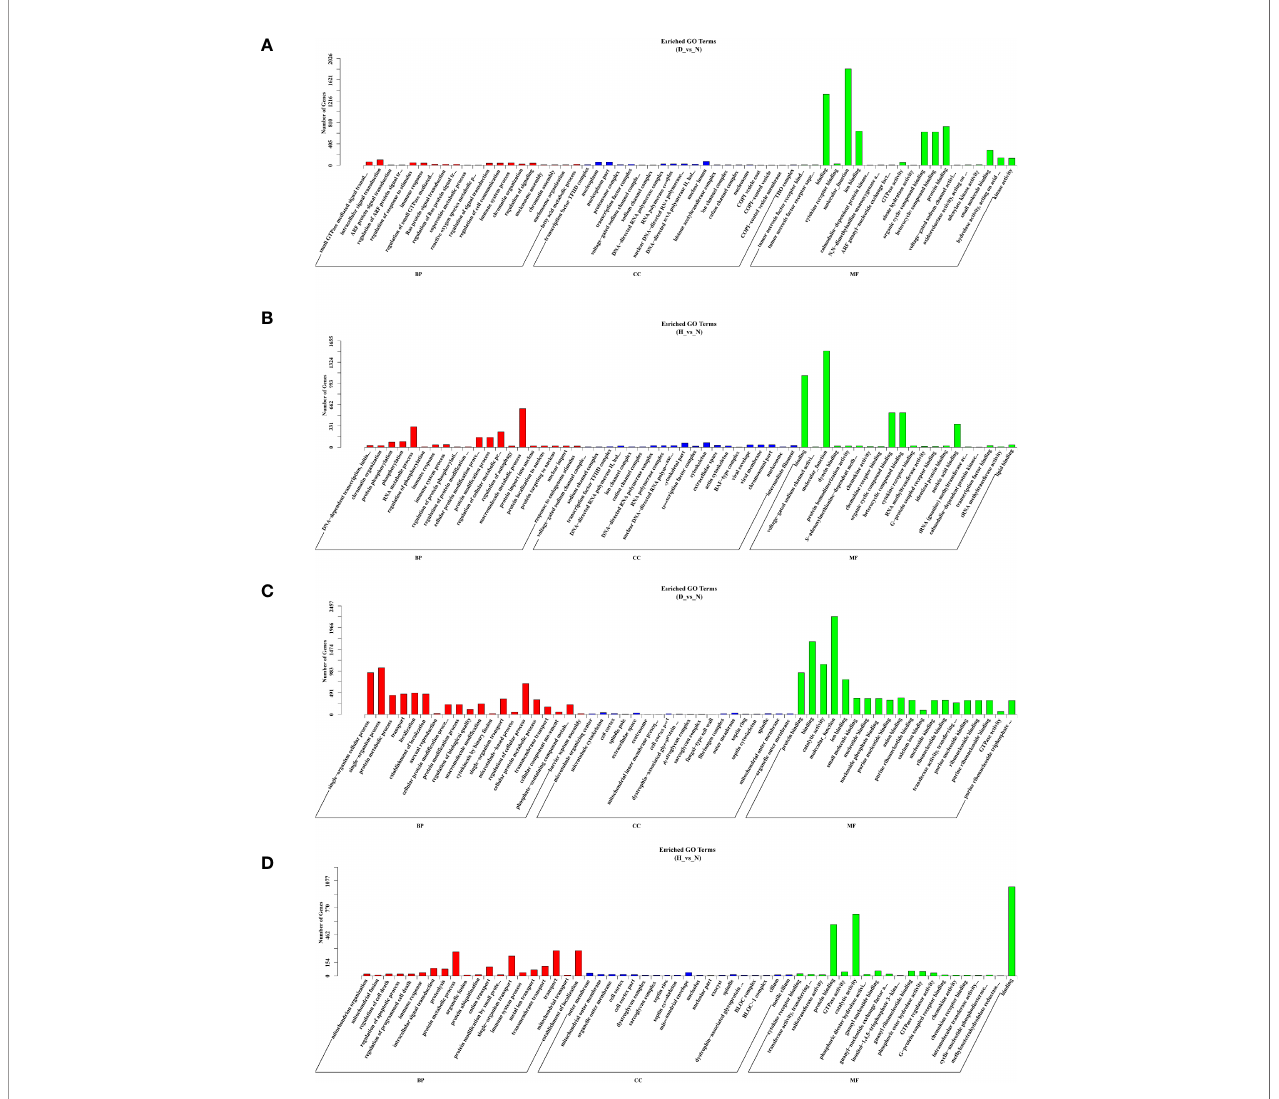
FIGURE 5 | GO enrichment analysis based on DELs ’ cis-target genes of D-vs-N group (A) , DELs ’ cis-target genes of H-vs-N group (B) , DELs ’ trans-target genes of D-vs-N group (C) , and DELs ’ trans-target genes of H-vs-N group (D) . GO enrichment analysis at each color represents a different biological process. Go terms distribution of target genes under molecular functions, cellular components, and biological